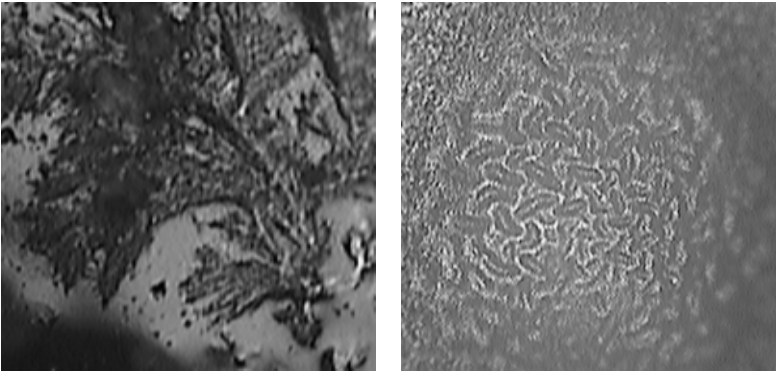
Figure 2. The surface of the microelectrode before (A) and after conditioning